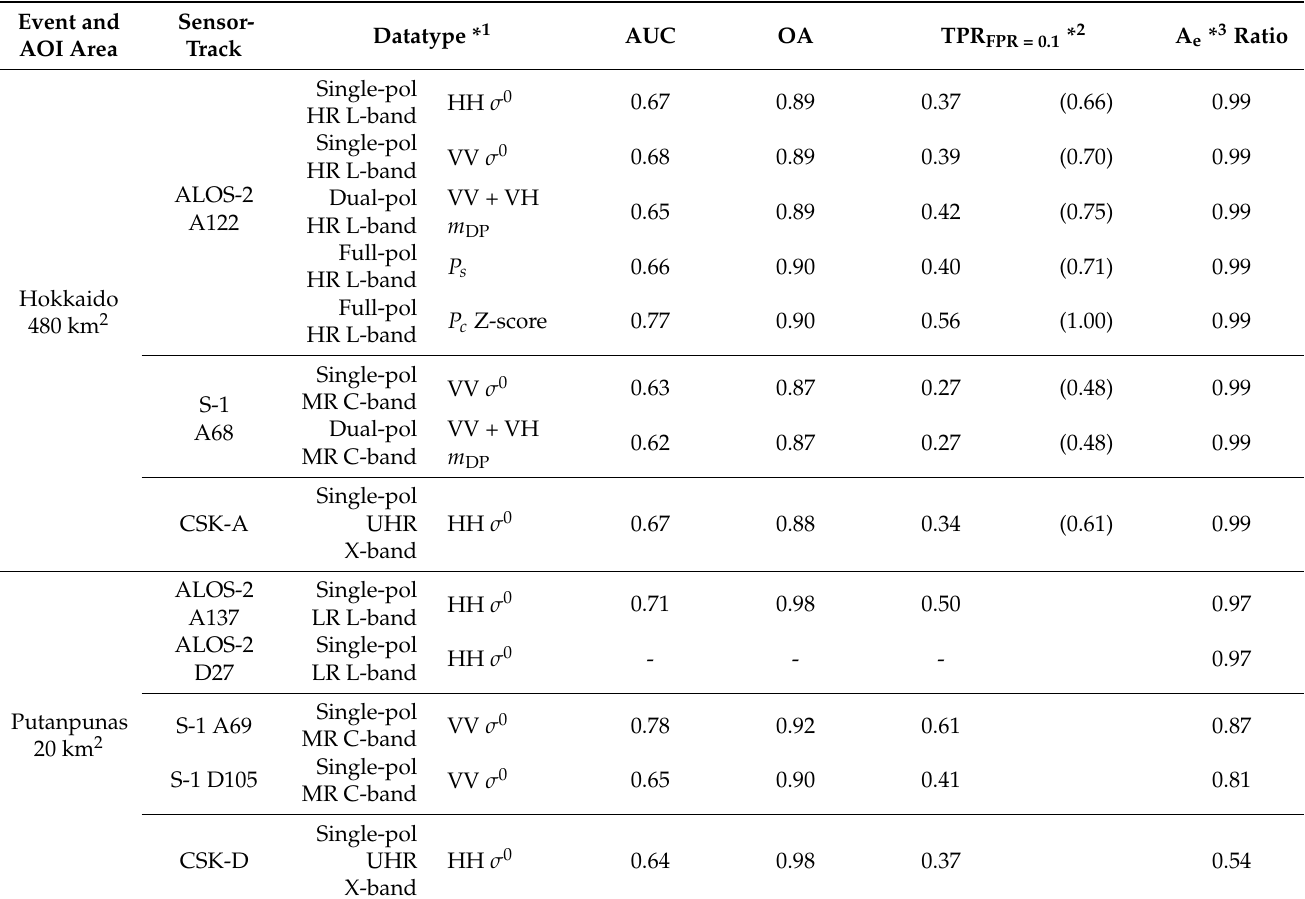
Table 2. Summary of full-area AUC, OA, TPR at PRF = 0.1 and the ratio of effective area (A e ) for the two case